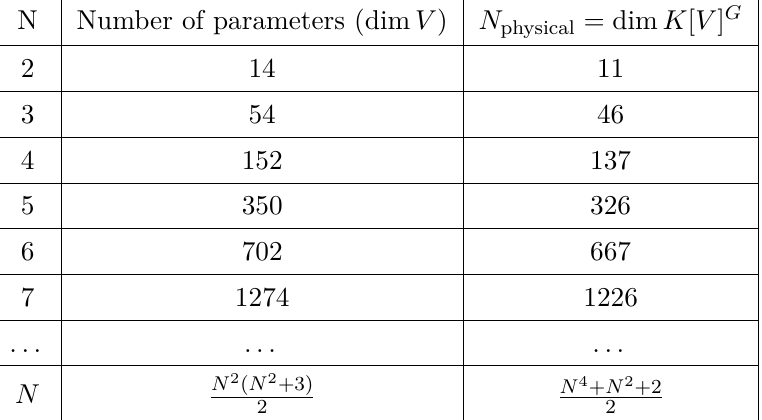
Table 1 . Physical parameters of the NHDM with a group of family transformations SU( N )